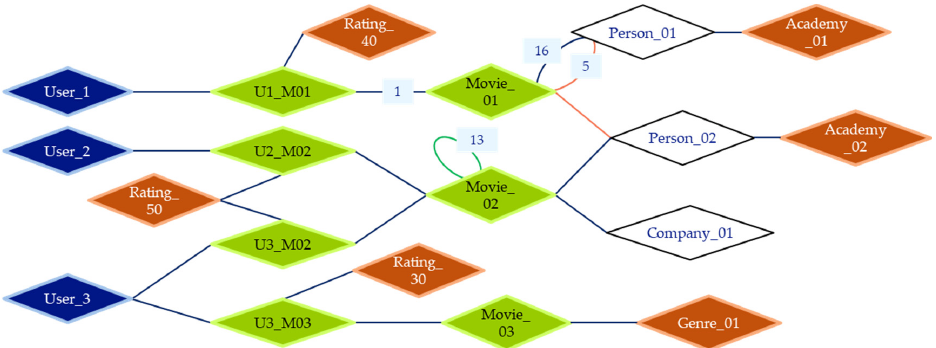
Figure 6. Instance graph.